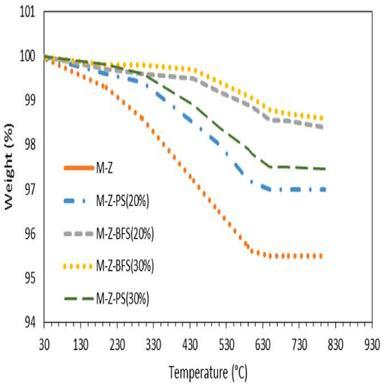
TGA analysis of M-Z, M-Z-PS20, M-Z-PS30, M-Z-BFS20, and M-Z-BFS30 membrane.